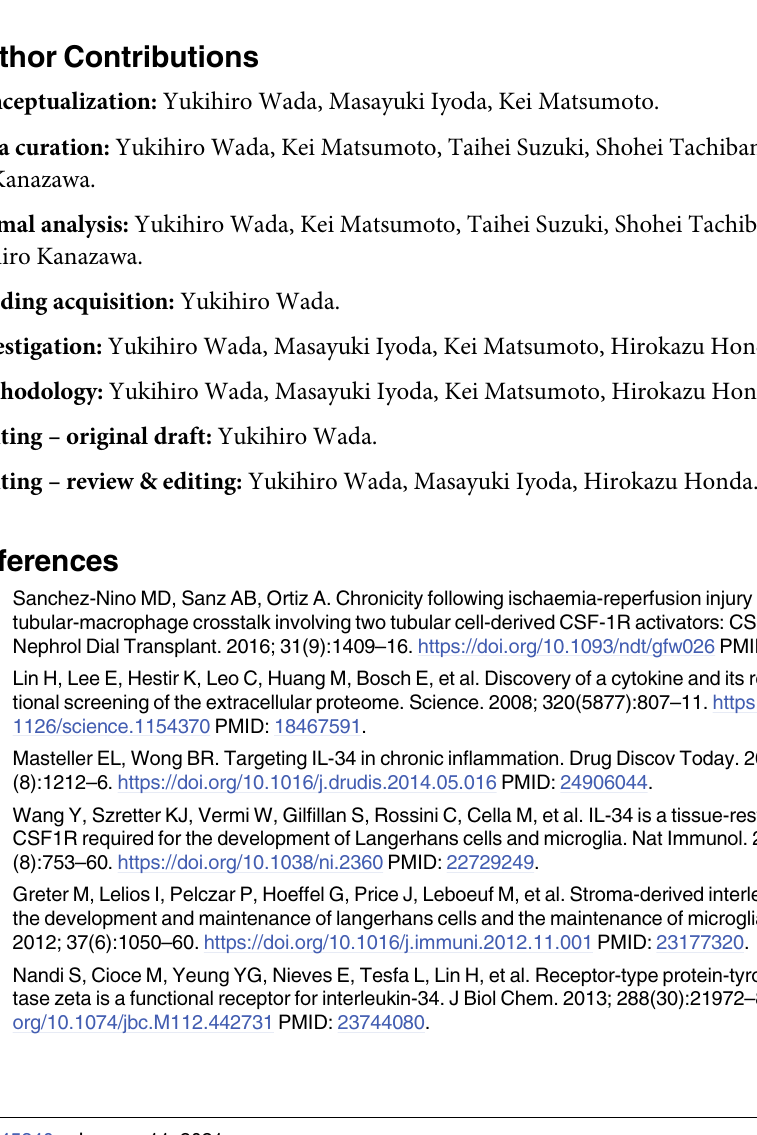
S5 Fig. CP-induced Akt phosphorylation in CP-N mice and CP-stimulated MRPTEpiC. Representative WB analysis for p-Akt and t-Akt in renal cortical tissues after stimulation with CP for 72 h among the NC, CP+V, and CP+anti-IL-34 Ab groups of mice ( A ). Representative WB analysis for p-Akt and t-Akt in MRPTEpiC after stimulation with CP for 6 h among the NC, CP+V, and CP+anti-IL-34 Ab groups ( B ). S1 Table. Information of primers used for real-time RT-PCR (TaqMan) assay. (RTF) S1 Raw image. Images of all original blot and gel images.